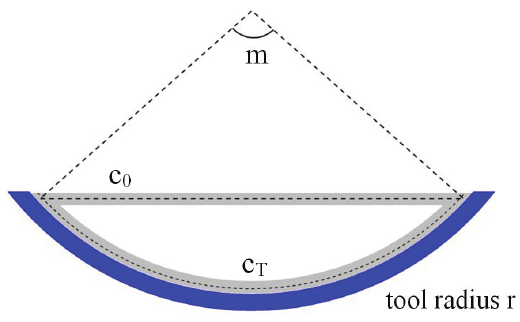
Figure 6. Sketch showing coupon over the tool: c loaded in the tool surface.